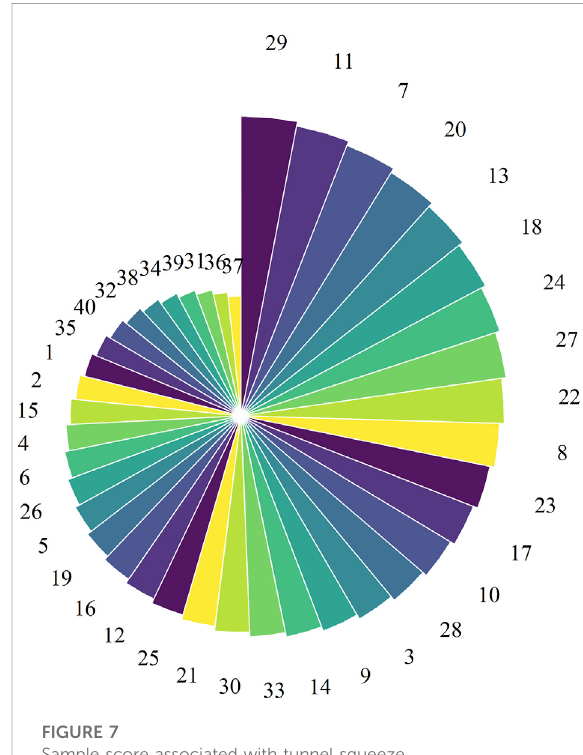
FIGURE 7 Sample score associated with tunnel